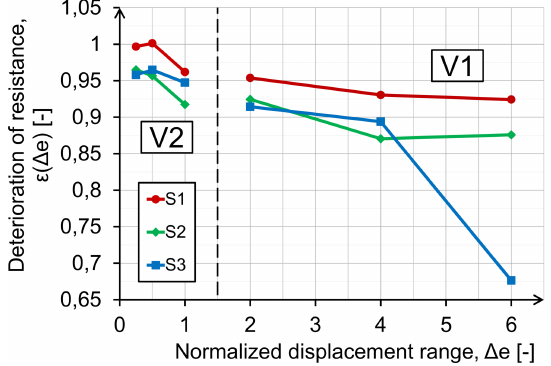
Figure 9: Deterioration of resistance ε ( ∆e ) evaluated from variable V1 and V2 loading histories.